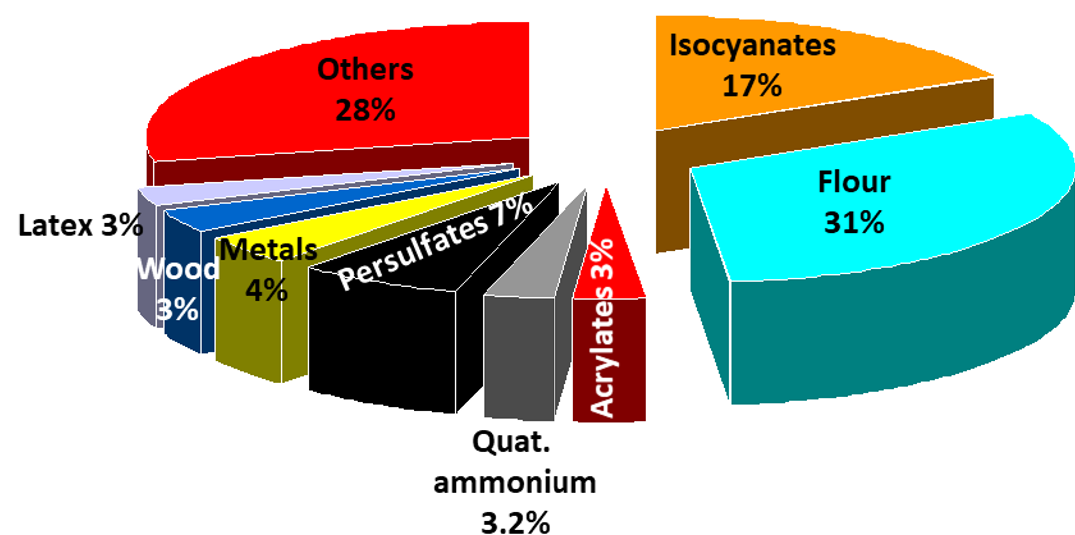
Figure 1. Distribution of the most frequent causes of occupational asthma, 2006–2015 ( n = 1167) (European network for the PHenotyping of OCcupational Asthma). From data of Vandenplas et al. [32].